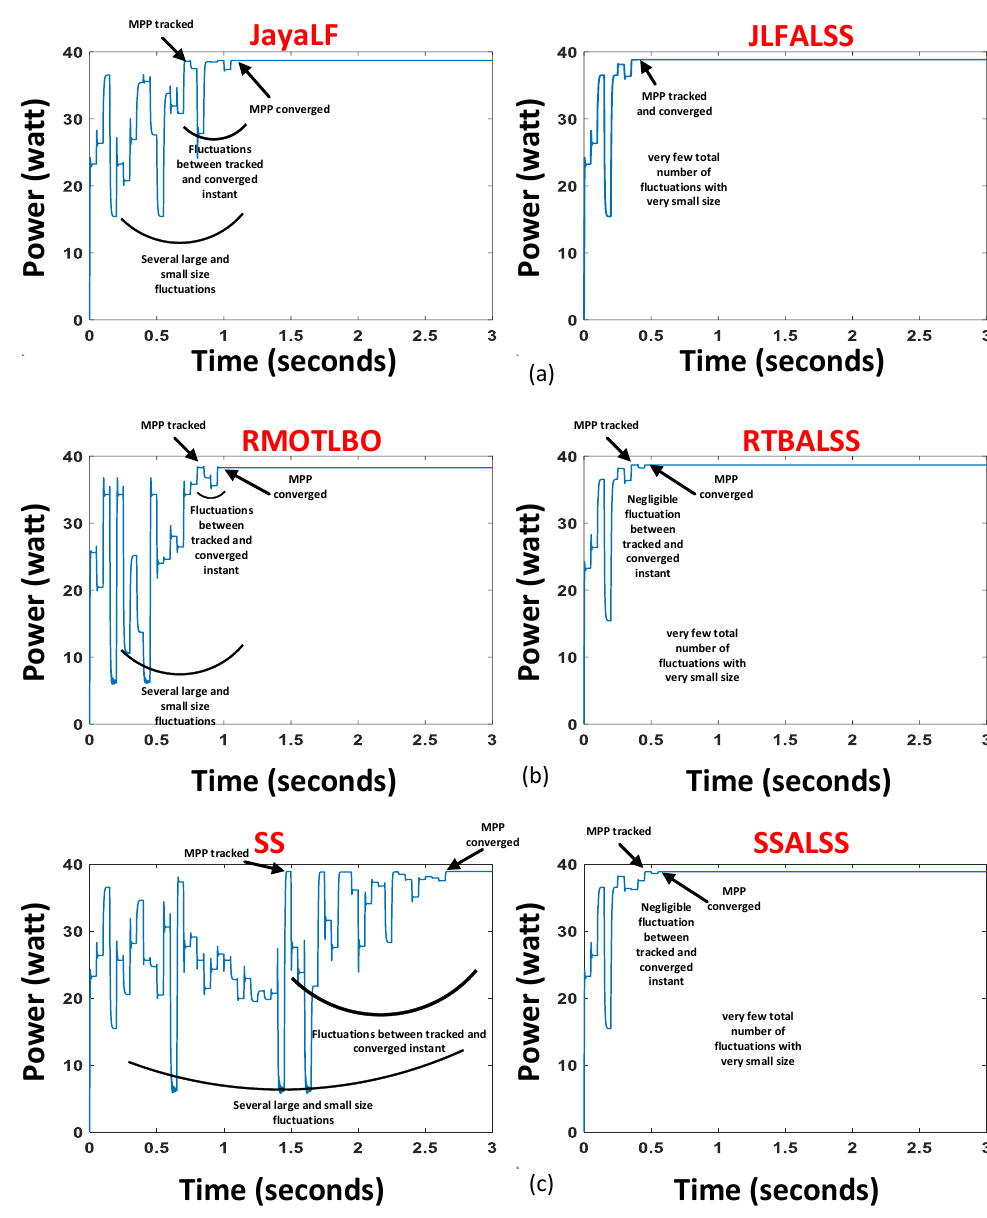
Figure 5. Comparison between ( a ) JayaLF and JLFALSS, ( b ) RMOTLBO and RTBALSS, and ( c ) SS and SSALSS for